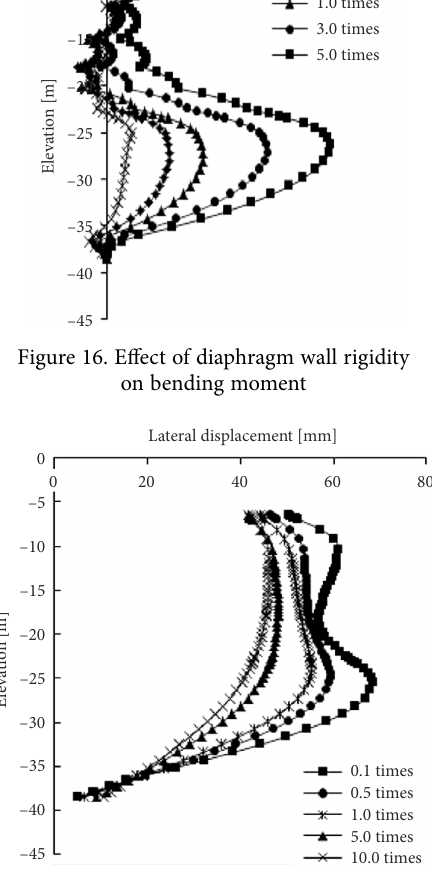
Figure 17. Effect of diaphragm wall rigidity on